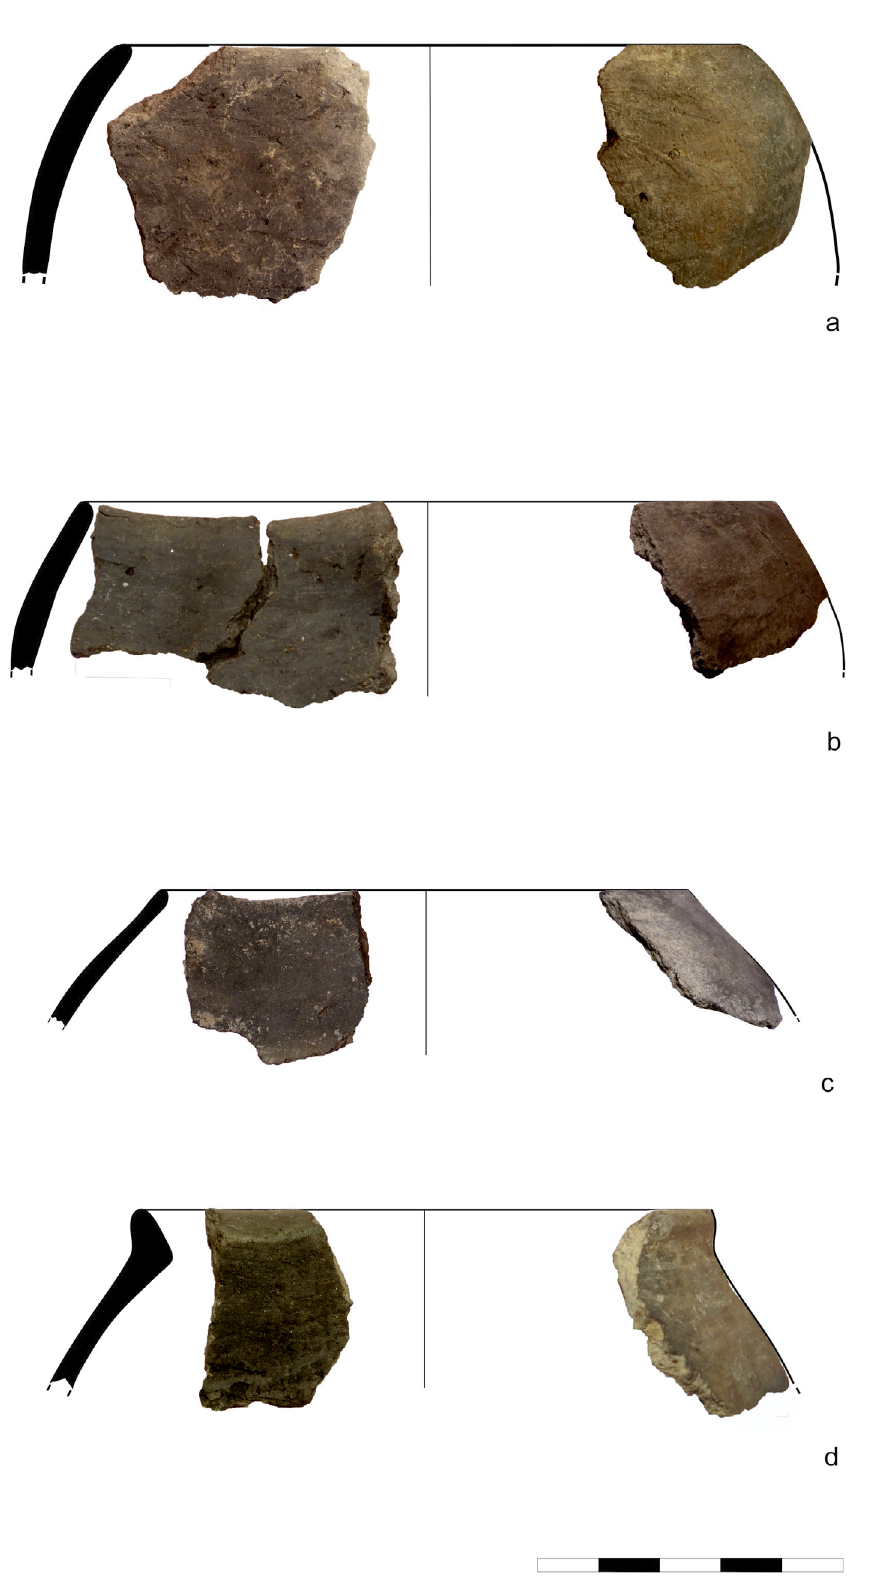
Figure 7. a-c) Hole-mouth cooking pots, d) closed cooking pot from